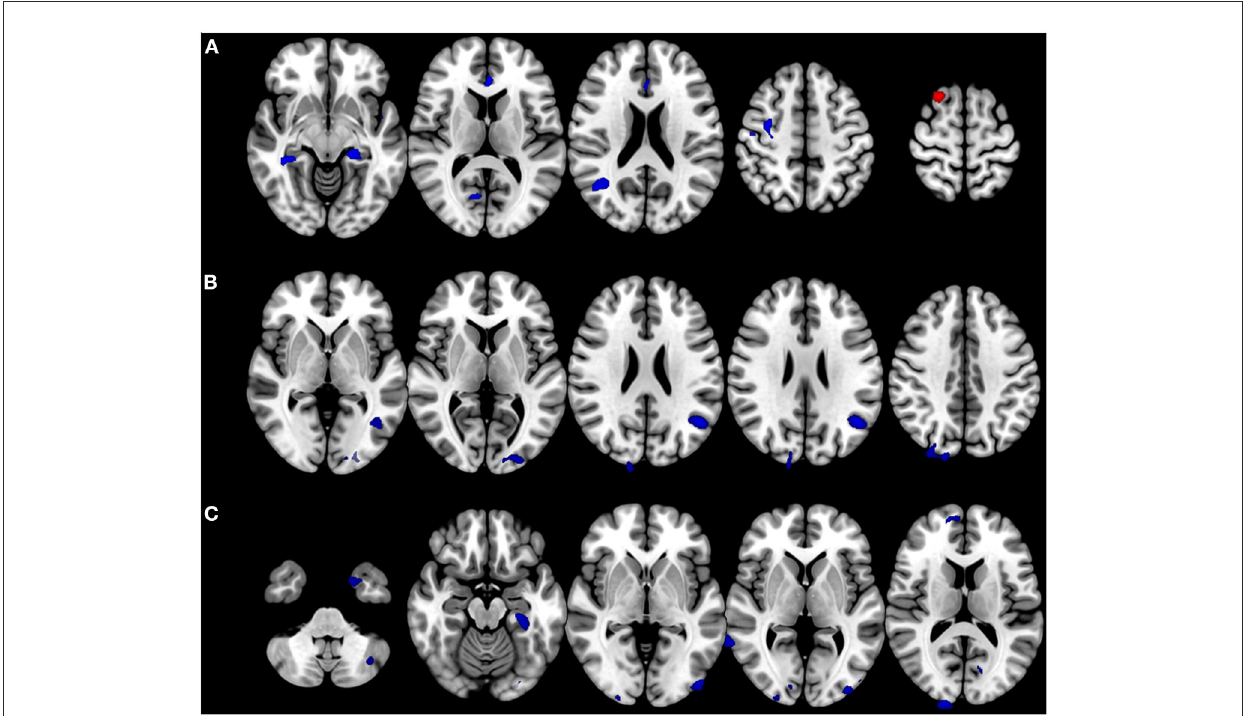
FIGURE3 Alteration in brain volumes in bilateral vestibulopathy. (A) Patient with bilateral vestibulopathy showed decreased volumes in the bilateral parahippocampal gyri, right precentral gyrus, anterior cingulate gyrus, and right middle temporal gyrus. Gray matter volume in the right superior frontal gyrus increased in patients with bilateral vestibulopathy. (B) The correlation analysis found gray matter volumes in the bilateral middle occipital gyri, right superior occipital gyrus, left angular gyrus, and right cuneus negatively correlated with DHI scores in patients with bilateral vestibulopathy (uncorrected p ≤ 0.001, cluster extents > 100 voxels). (C) The correlation analysis found gray matter volumes in the right angular gyri, bilateral parahippocampal gyri, right middle temporal gyrus, right cuneus, bilateral inferior occipital gyri, left middle occipital gyrus, right superior frontal gyrus, left fusiform gyrus, bilateral caudate, left cerebellar crus, and bilateral calcarine gyri negatively correlated with VADL scores in patients with bilateral vestibulopathy (uncorrected p ≤ 0.001, cluster extents > 100 voxels).